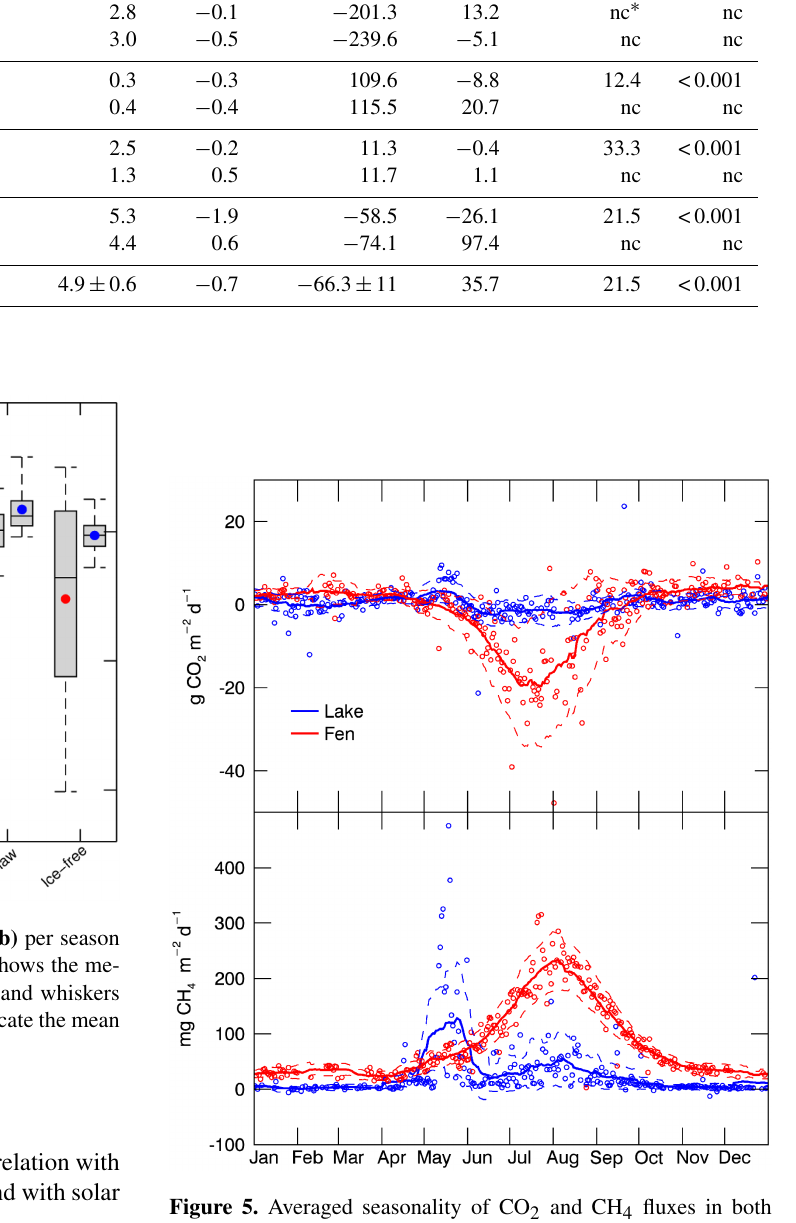
Figure 5. Averaged seasonality of CO 2 and CH 4 fluxes in both ecosystems. Dots show daily means across the whole measurement period; lines are a smoothing filter of the daily mean with a 30-day window. Dashed lines show the standard deviation around the daily means, smoothed with a 30-day